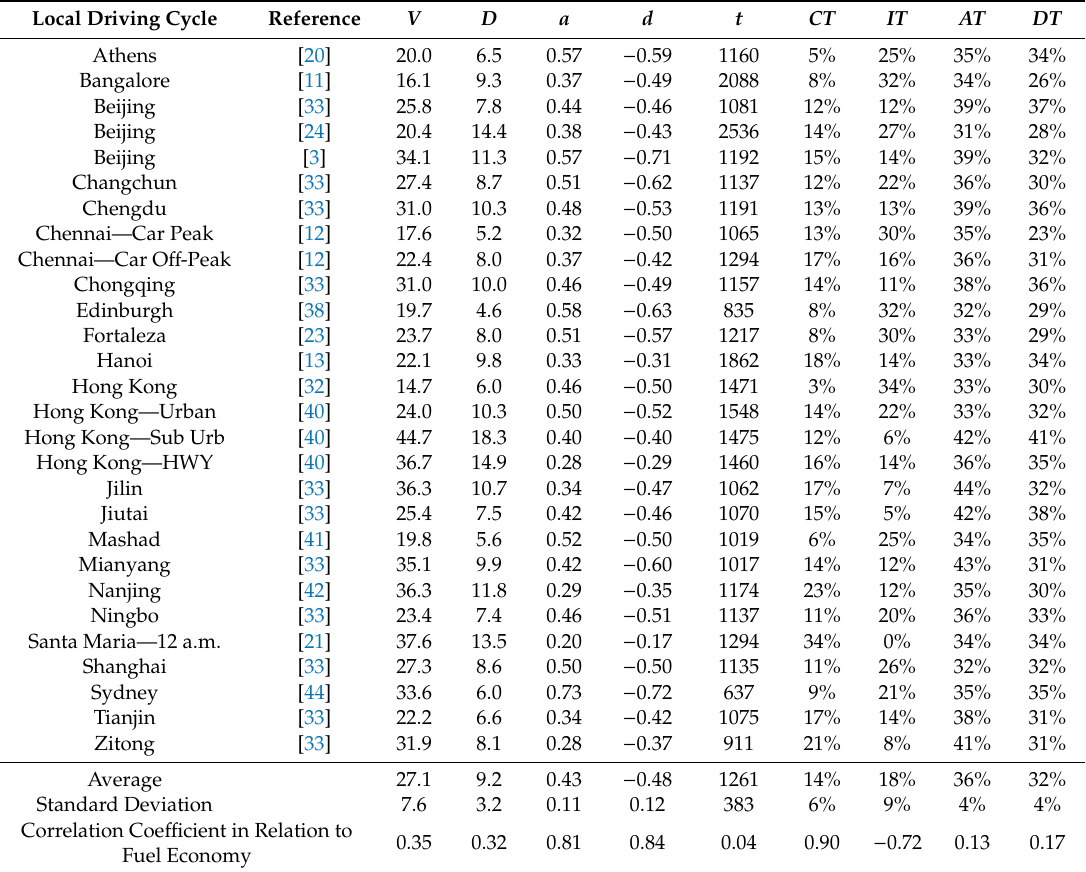
Table 7. CP ENV of LDCs for passenger